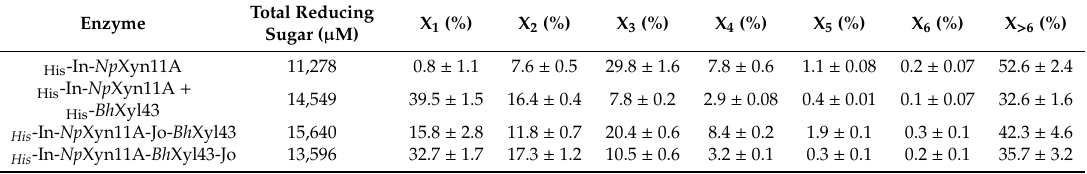
Table 4. Amount of equivalent of reducing sugar as determined by DNS assay after 24 h of hydrolysis at pH 7 and percentage of xylooligomers of DP ranging from 1 to 6 and oligomers of DP > 6. Hydrolysis conditions: 1 nM of enzymes, 37 ◦ C 1% BWX after 24 h. Representation of the average of experiments in triplicate. The value shown as ± mean standard deviation of replicate n =